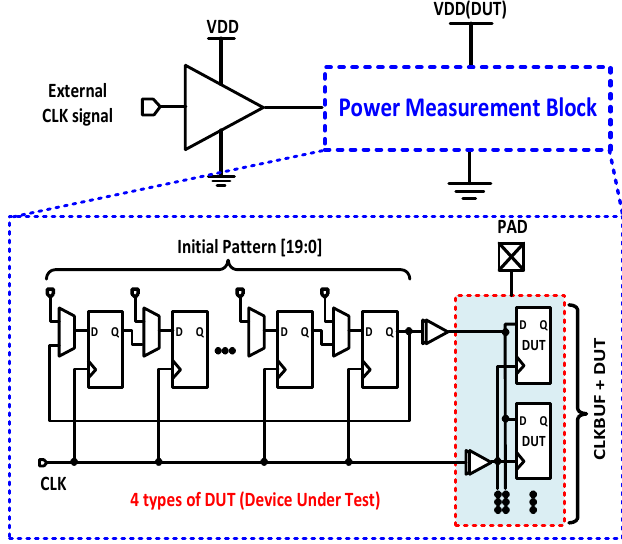
Figure 11. Block Diagram of Power Measurement.